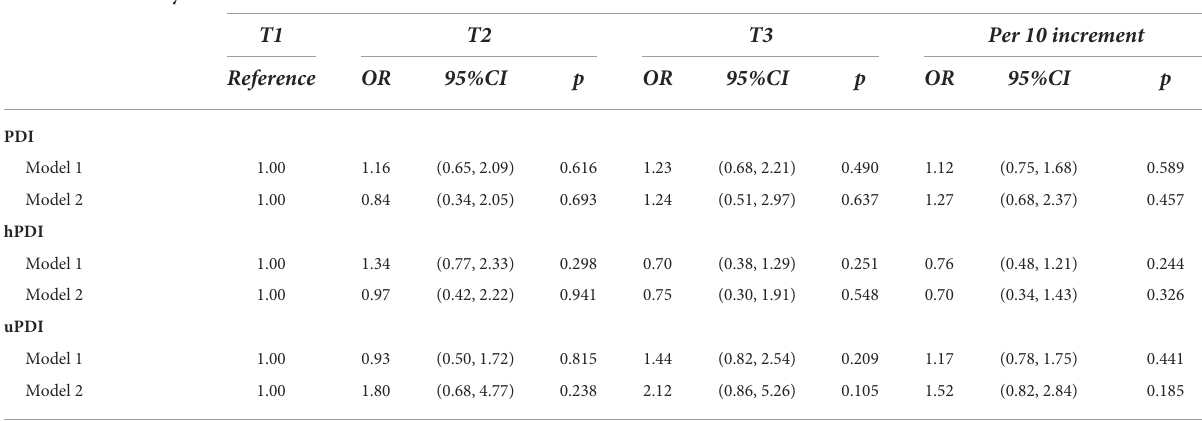
TABLE 5 Associations of plant-based diet index scores with abdominal